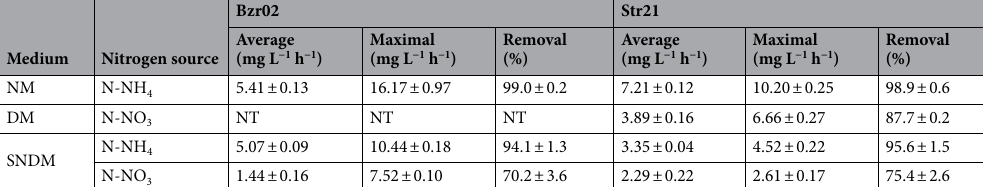
Table 2. Nitrogen removal rates by strains Bzr02 and Str21 in different nitrogen media. NM: nitrifying medium; DM: denitrifying medium; SNDM: simultaneous nitrifying-denitrifying medium; NT: Not transformed. Values represent the mean and the standard error (n =